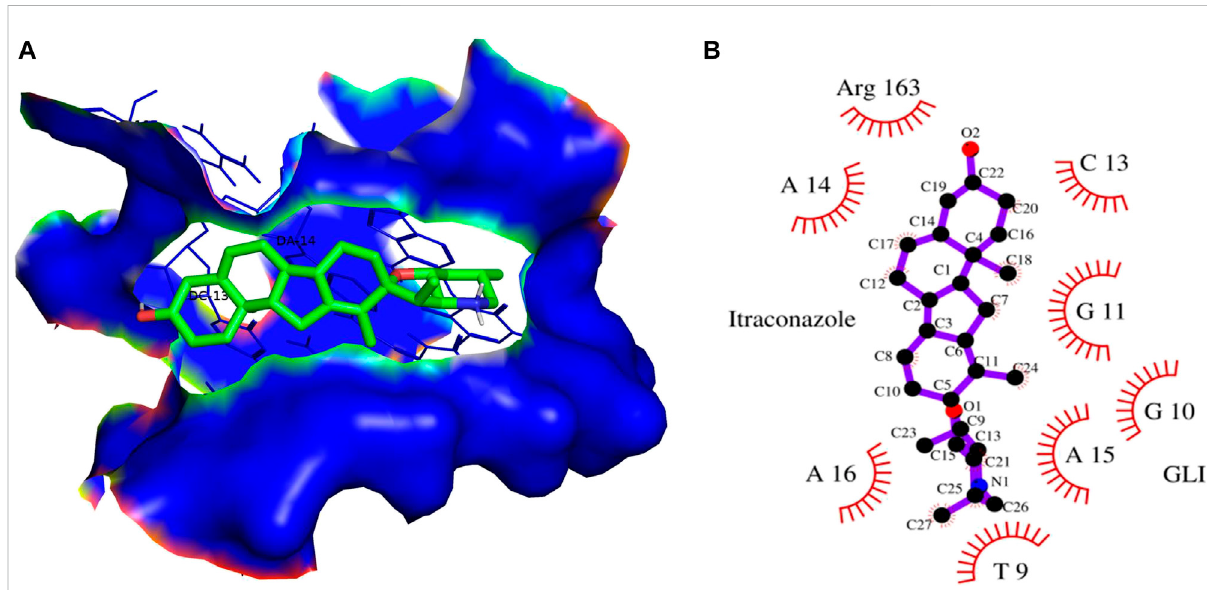
FIGURE 12 (A) 3D Interaction complex of itraconazole with GLI-DNA protein; where blue shows the hydrophobic interactions and green shows the ligand molecule (B) 2D Interaction complex of itraconazole with GLI-DNA; where red shows the hydrophobic interactions and purple shows the ligand molecule.